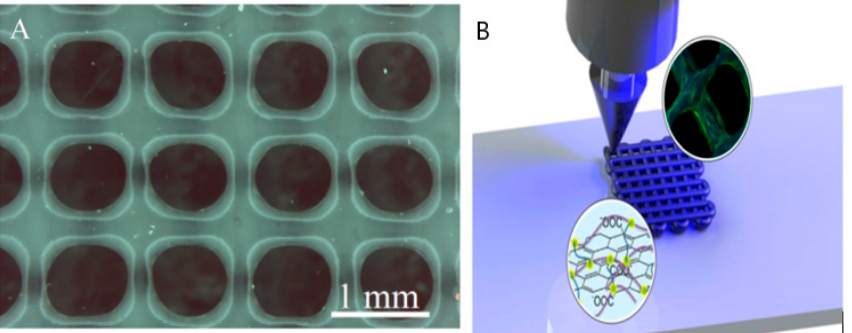
Figure 5. PTMC scaffold created by a 3DP nozzle system ( A ) and illustration of printer nozzle during fabrication ( B ).